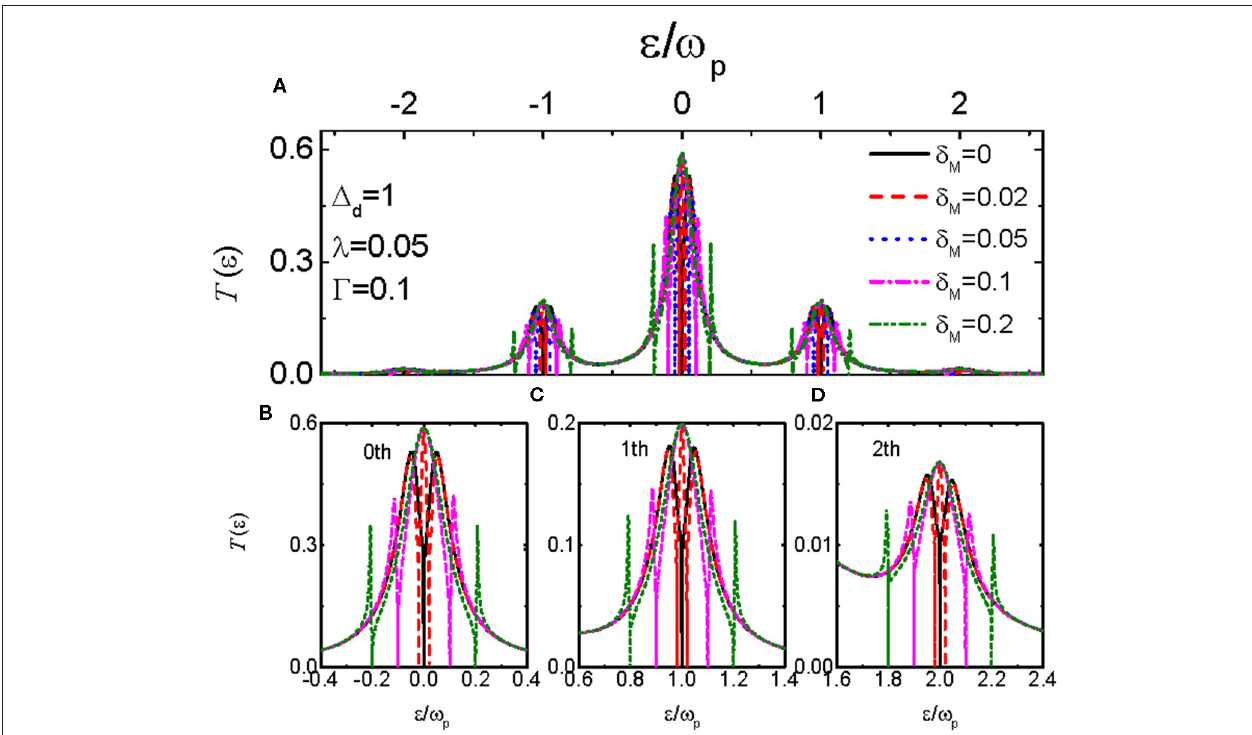
ω p , λ 0.05 and different values of overlap strength between the MBSs δ M . Panel (A) = =